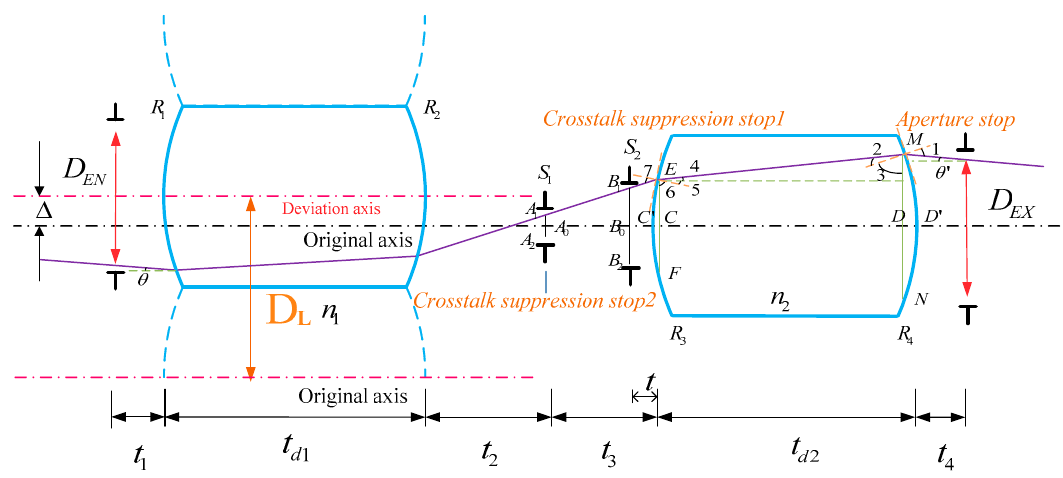
Figure 4. Schematic diagram of the optical path to determine the aperture size using the edge light (purple: SFOV-IFOV).